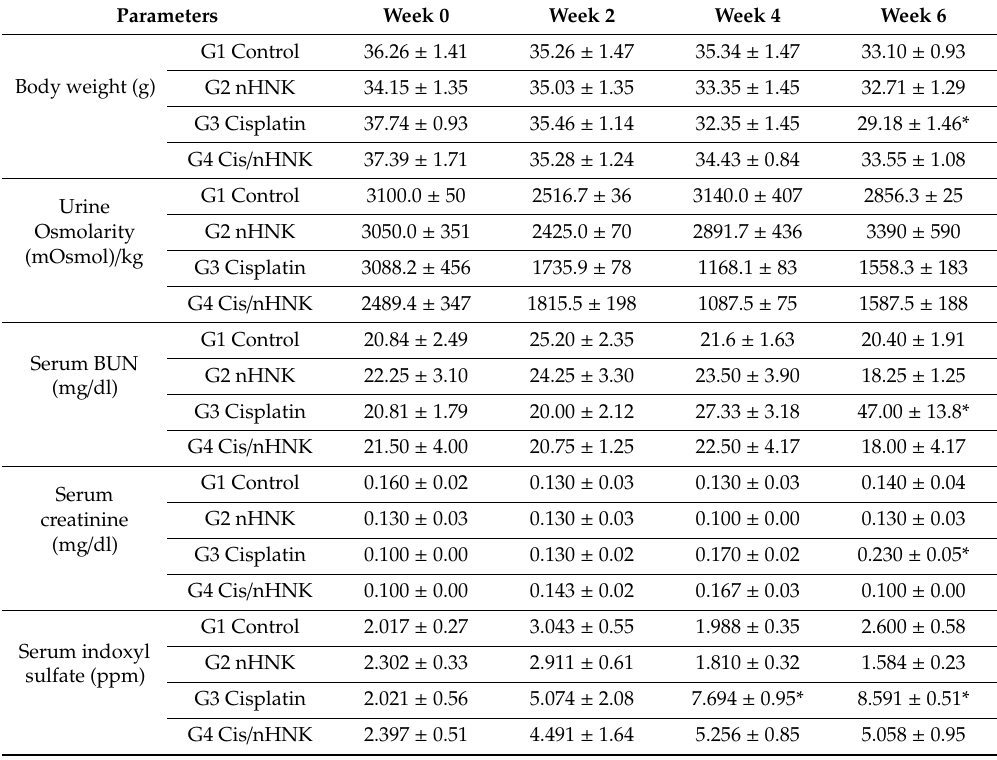
Table 1. Kidney physiological parameters (value ±